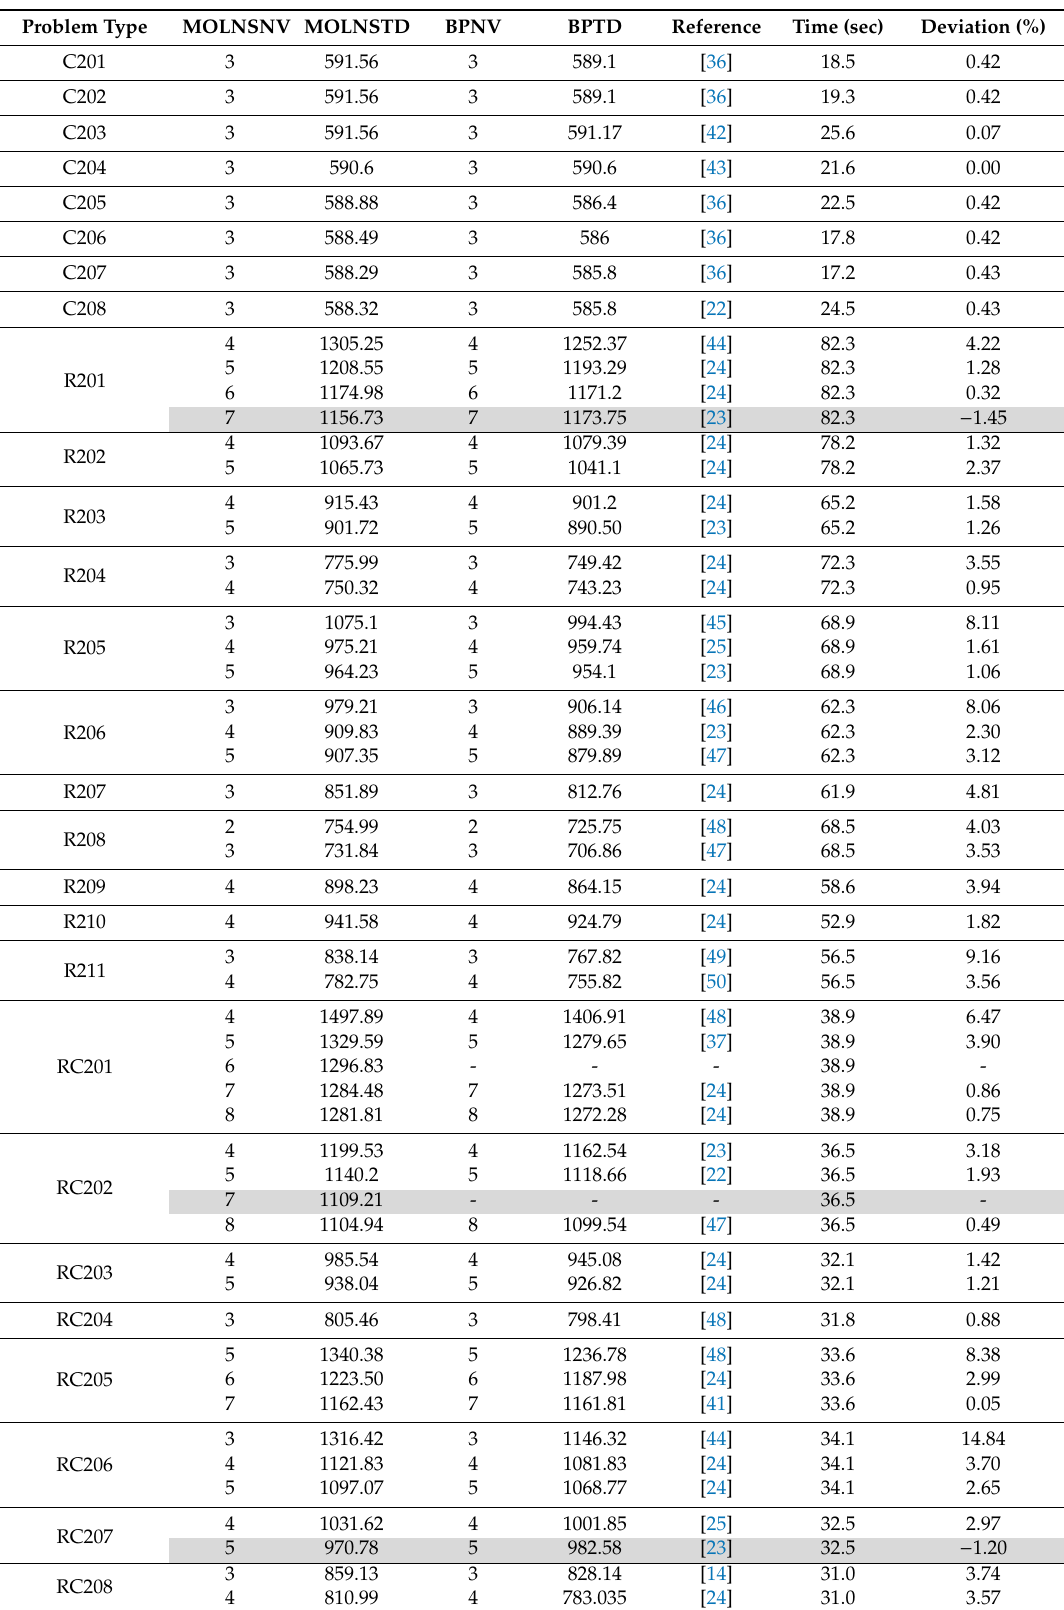
Table 2. Solomon instances with long scheduling horizon: comparison of our MOLNS with the best-published